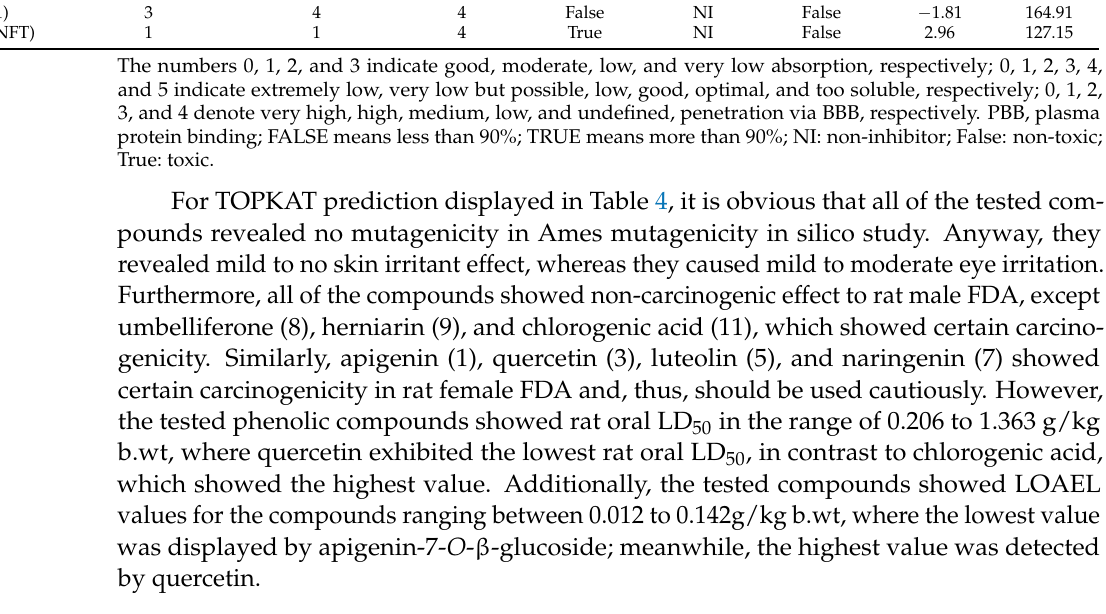
Table 4. TOPKAT prediction of the major polyphenolic compounds of Matricaria chamomilla